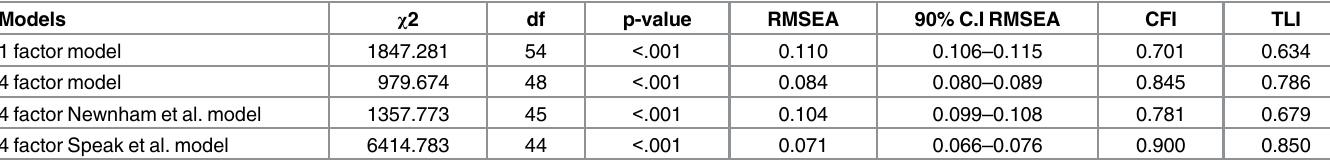
Table 2. Comparison of model fit for the Confirmatory Factor Analysis (N = 2722). Models